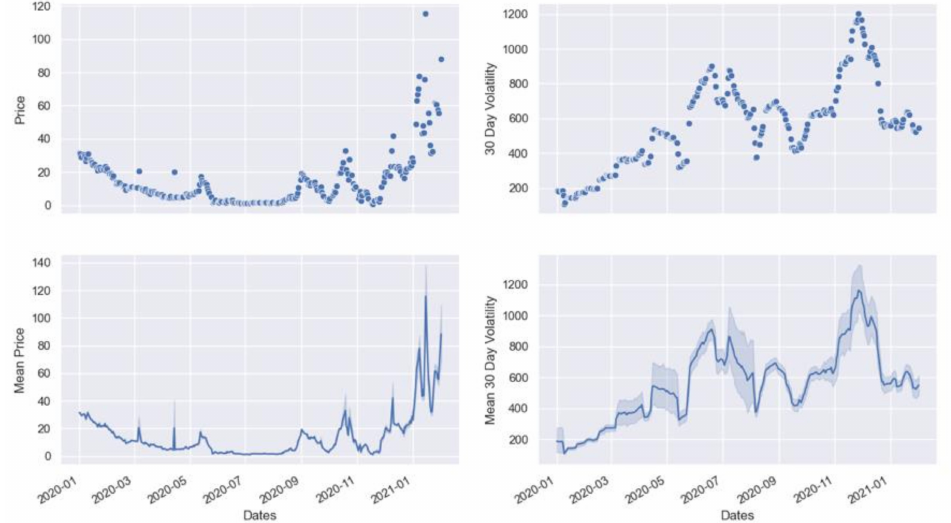
Figure 13. This figure represents the intraday price levels for NO1 power including its confidence levels on the left side and the 30-day volatility including its confidence levels on the right side. Figures 7, 8 and 11–14, got generated using the same code in